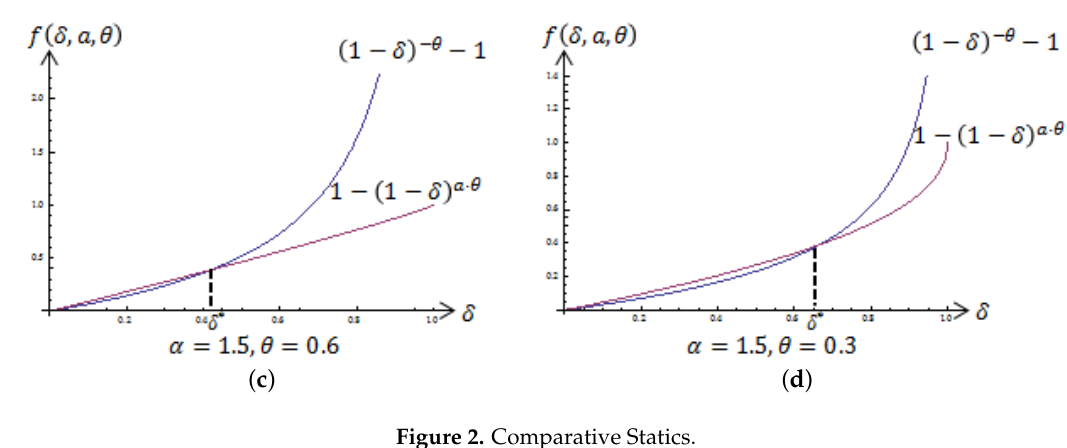
Figure 2. Comparative